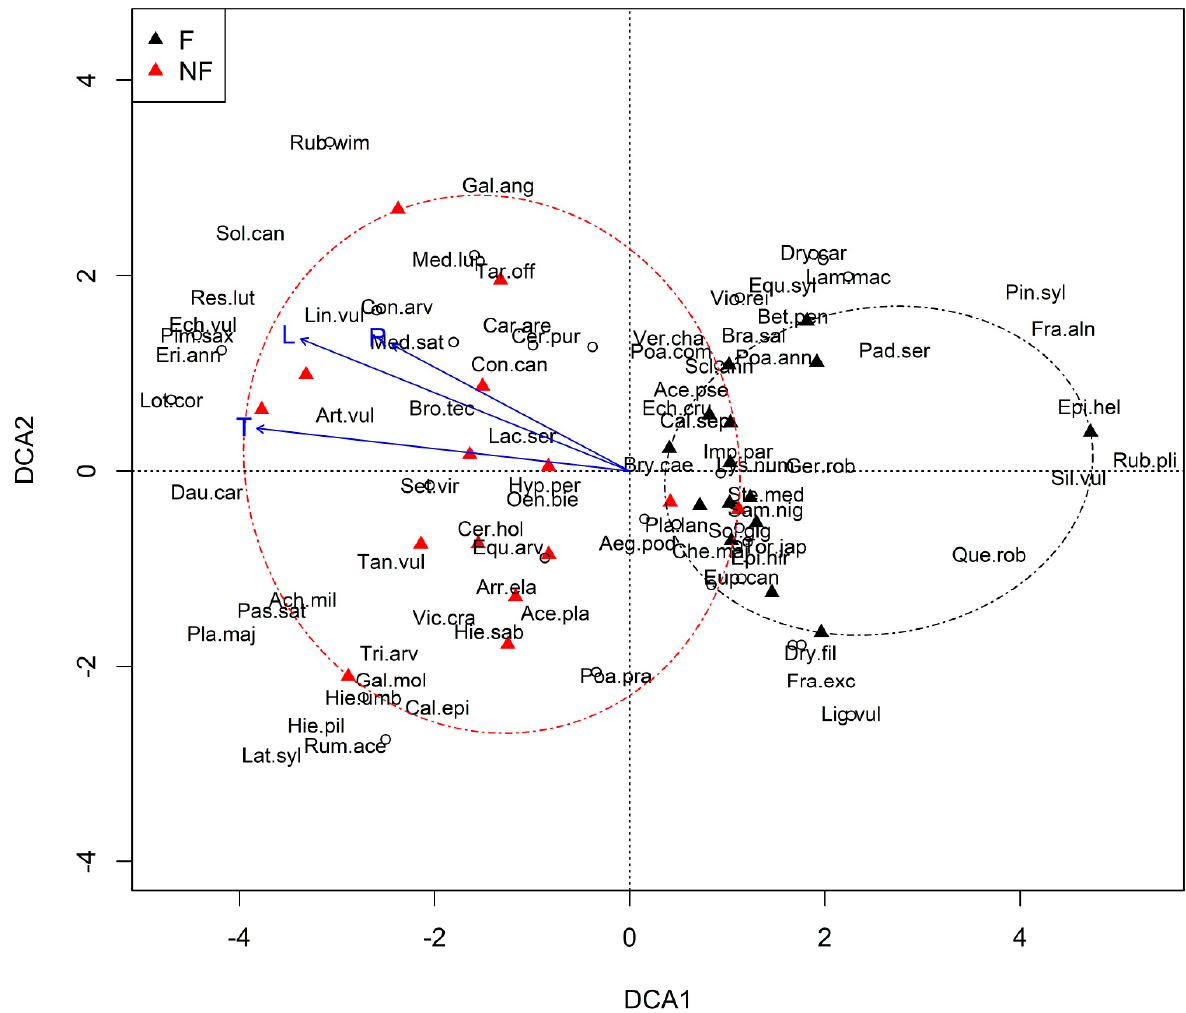
Figure 2. The species composition differentiation on the F and NF plots presented by DCA analysis. The mean Ellenberg indicator values (EIV) were passively projected with significance assessed by applying the Monte Carlo test at 999 permutations. Explanations: see section Materials and Methods (subsection: